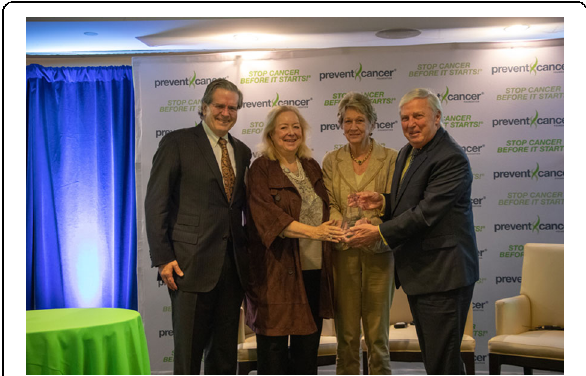
Fig. 1 Recently honored Andrew C. von Eschenbach, M.D., with the 2019 James L. Mulshine, M.D., Leadership Award for his work leading the National Lung Screening Trial (NLST), the first largescale clinical trial for low-dose computed tomography (CT) lung cancer screening. The award was presented on October 10, 2019, at the 16th annual Quantitative Imaging Workshop: Lung Cancer, COPD, and Cardiovascular Disease. Andrew C. von Eschenbach, M.D., receives the James L. Mulshine, M.D., Leadership Award from the Prevent Cancer Foundation. Left to right: Dr. Mulshine; Claudia